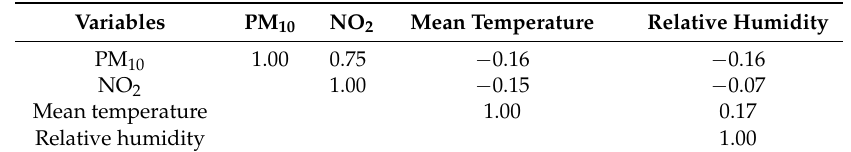
Table 2. Pearson’s correlations between daily air pollution concentrations and meteorological factors (2006–2010).